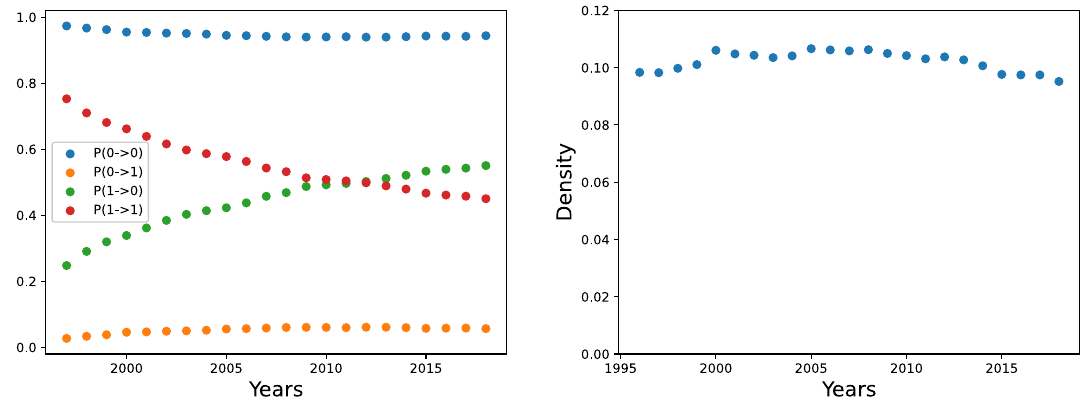
Figure 1. Left: transition probabilities between the binary states of the export matrix M . The strong persistency implies the importance of the study of the appearance of new products (called activations ) with respect to the unconditional presence of one matrix element (in the following, full matrix ). Right: the fraction of nonzero elements in M as a function of time. A strong class imbalance is